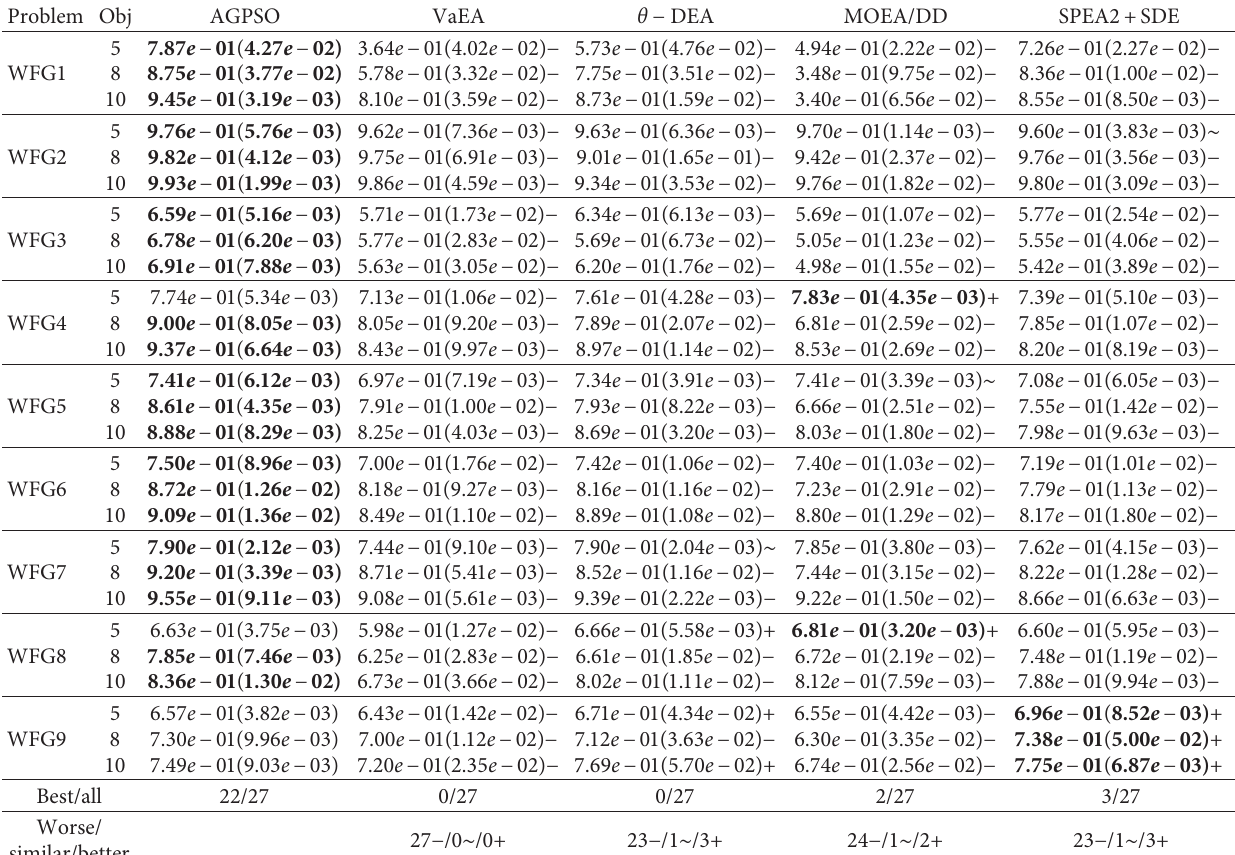
Table 4: Comparison of results of NMPSO and four current MOEAs on WF1-WFG9 using HV. Problem Obj AGPSO